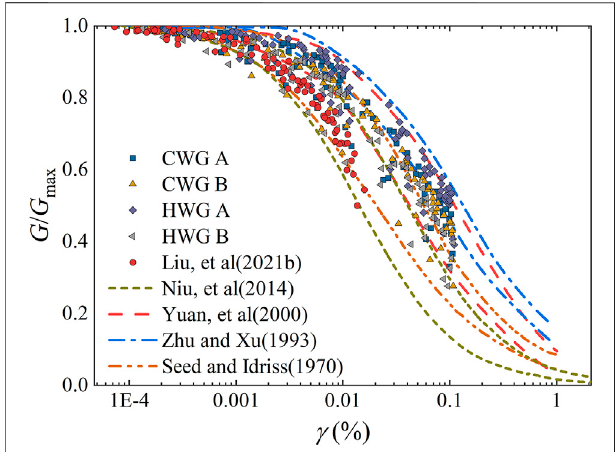
FIGURE 15 | Results of normalized dynamic shear modulus. Data source:SeedandIdriss(1970);ZhuandXu(1993);Yuanetal.(2000);Niuetal. (2014); Liu X. et al.